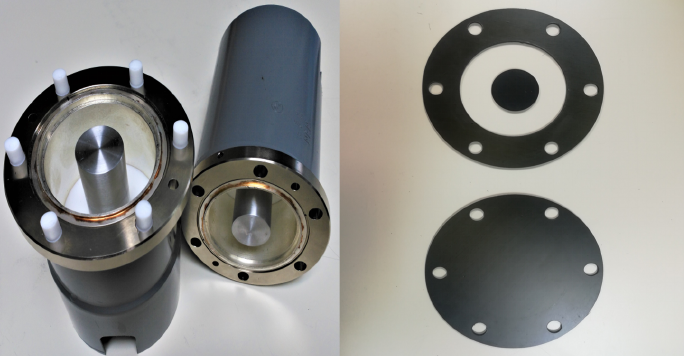
Figure 13. Two 1/8 EIA to N female adapters used as sample holder ( left ), reference ( upper right ) and load ( lower right )